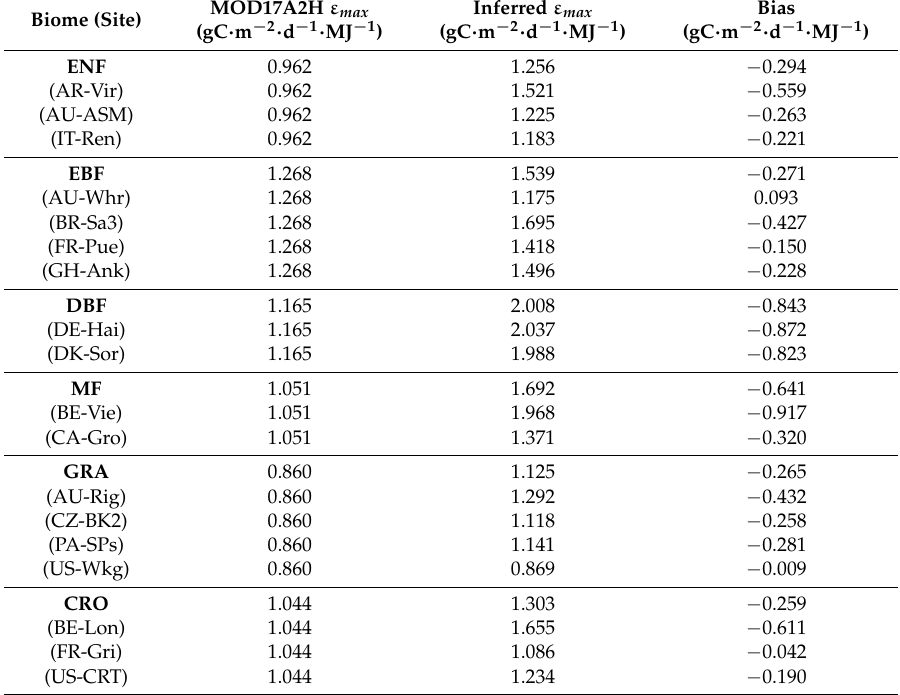
Table 5. Comparison of the inferred ε max and MOD17A2H ε max for various biomes. ENF: evergreen needleleaf forests; EBF: evergreen broadleaf forests; DBF: deciduous broadleaf forests; MF: mixed forests; GRA: grasslands; CRO: